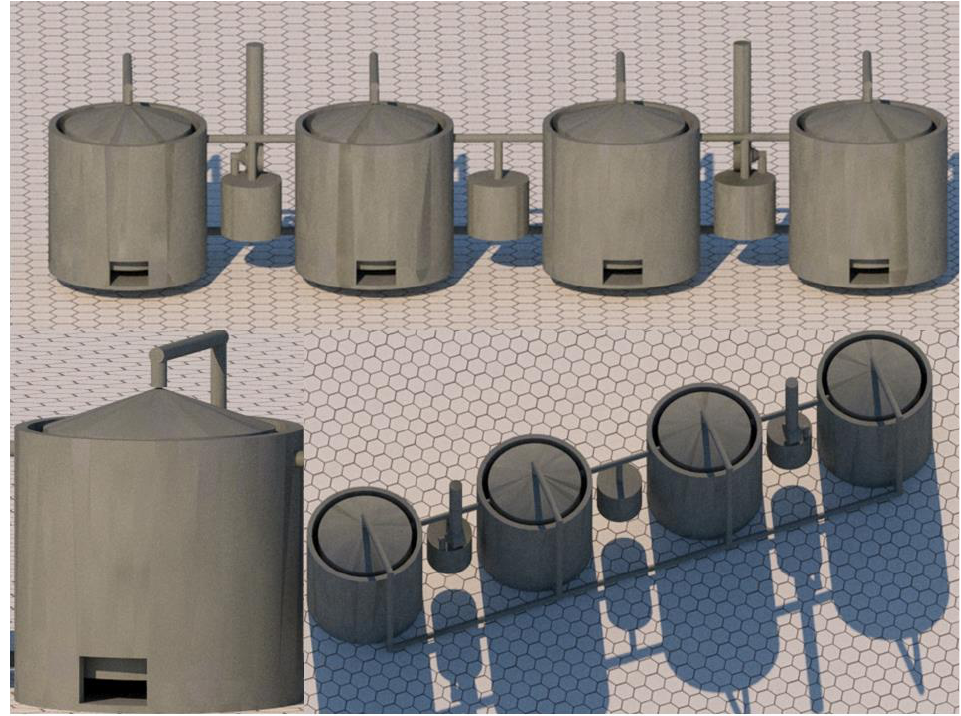
Figure 5. Design of a metallic industrial kiln.